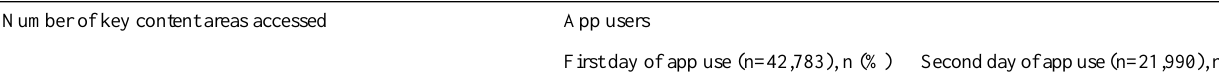
Table 5. Comparison of key content area usage, by first and second day of app use.